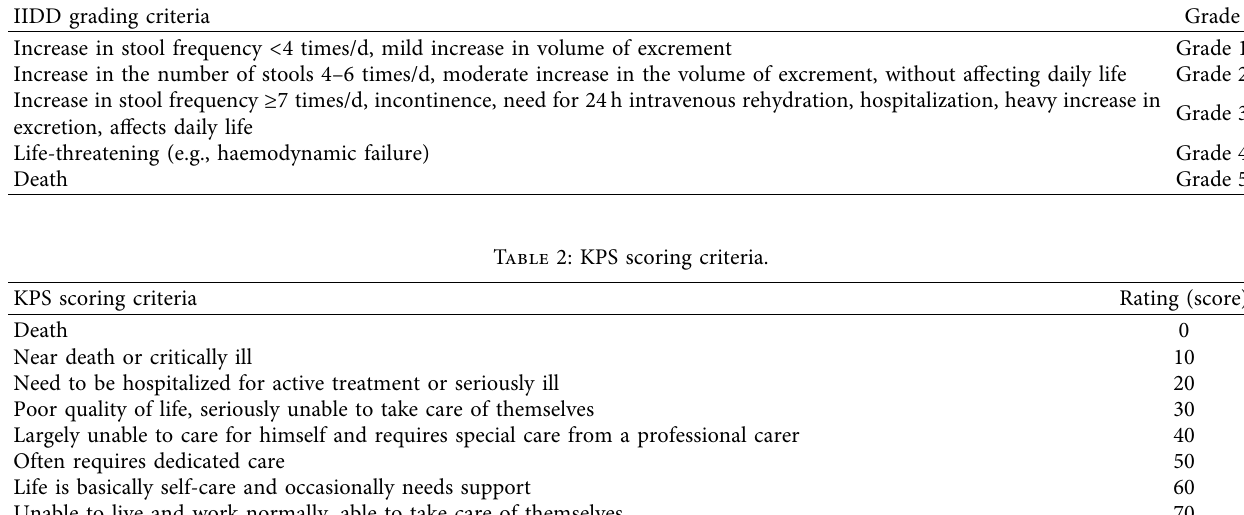
Table 1: IIDD grading criteria.